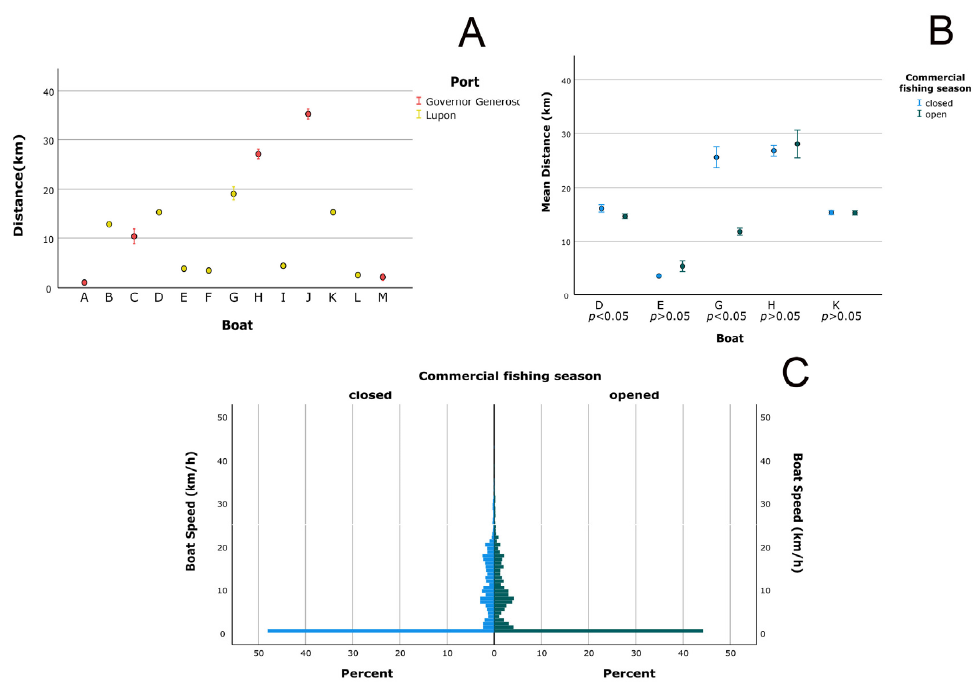
Figure 5. Mean distance from homeport to fishing ground with error bars, 95% CI ( A ); the other graph also shows the mean distance travelled by fishers from the homeport depending on the fishing season (closed, open) with error bars, 95% CI ( B ); the histograms on boat speed compared speed classes between fishing seasons (open and closed) in Davao Gulf ( C ).